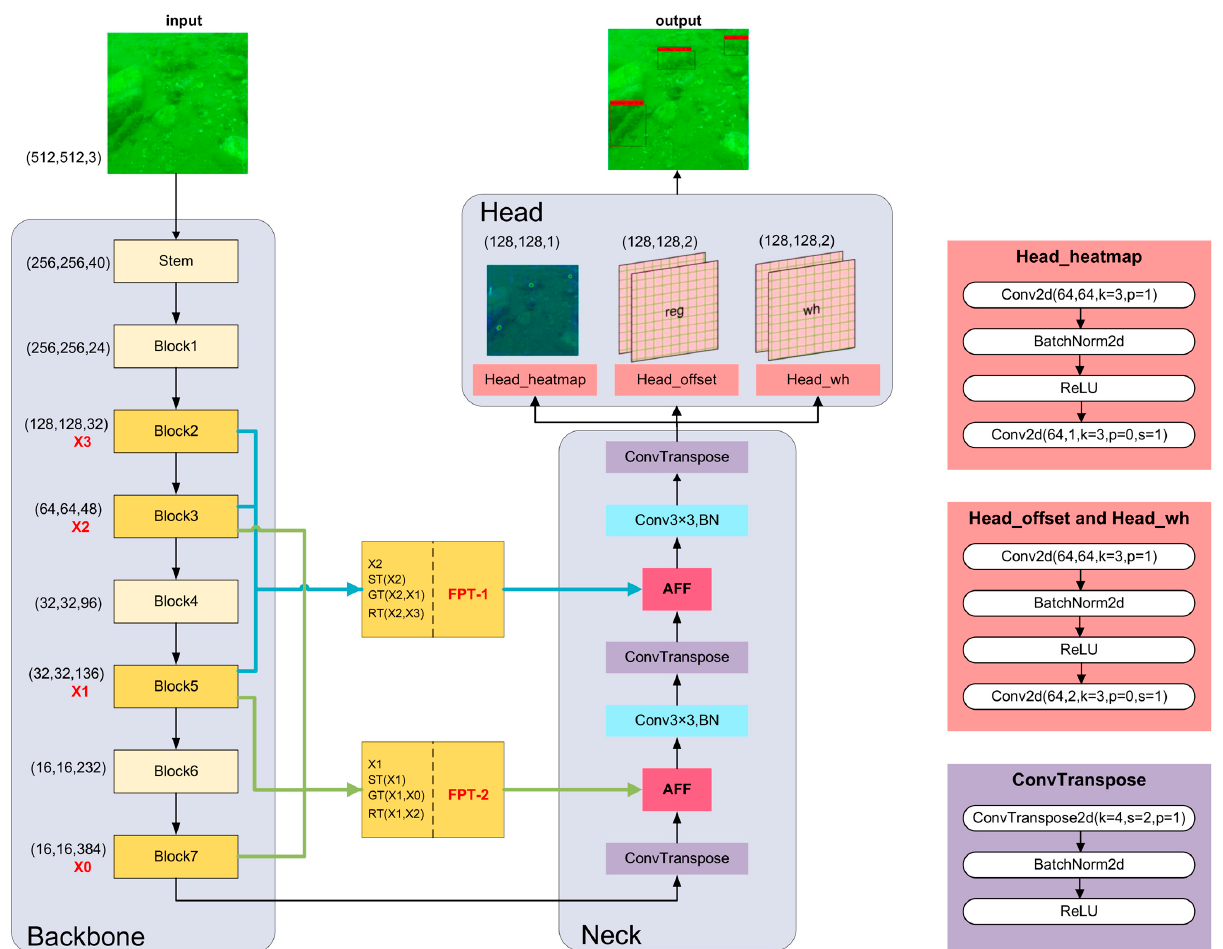
Figure 1. FA-CenterNet network structure. FA-CenterNet uses EfficientNet-B3 as its backbone